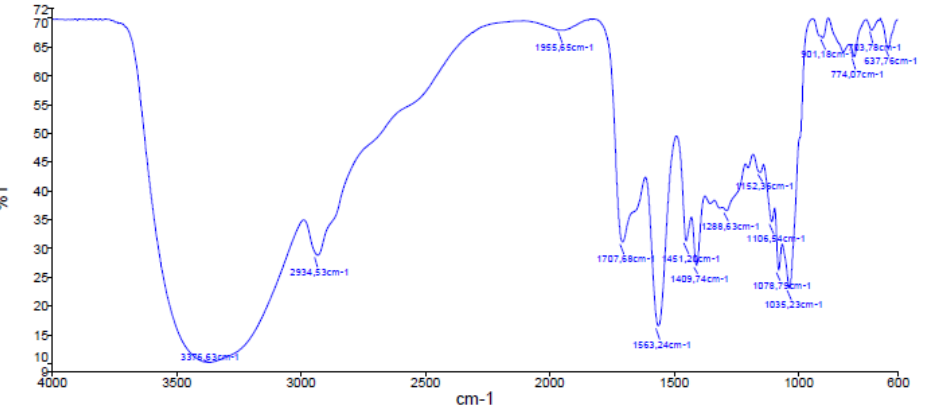
Figure 2. IR spectrum of BB graft copolymer.